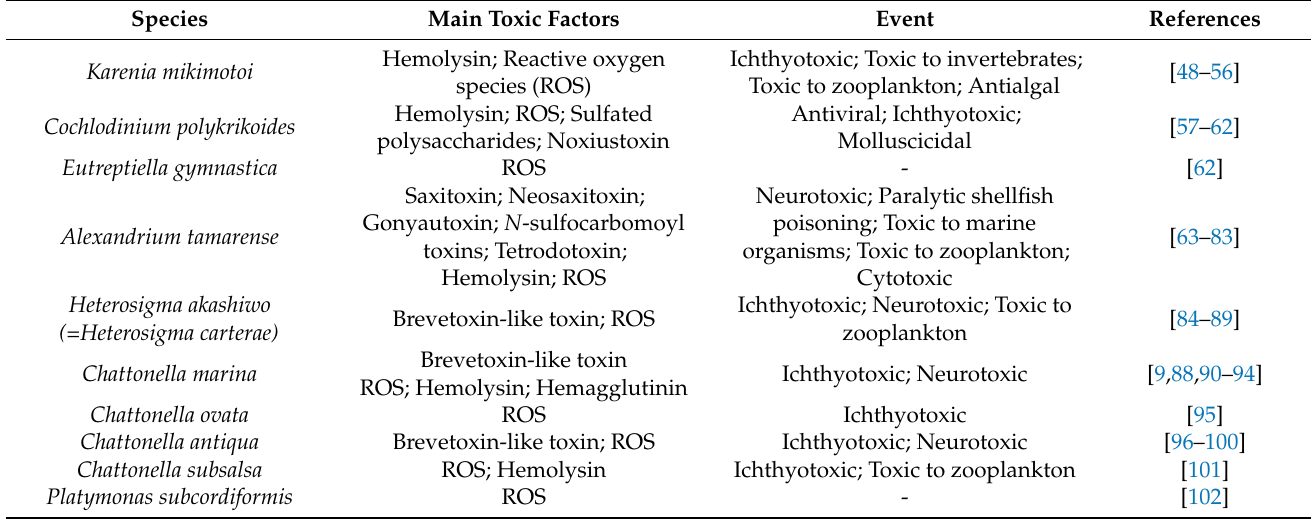
Table 1. Harmful effect of HAB-forming species and their toxins (directly citing reviews of Landsberg